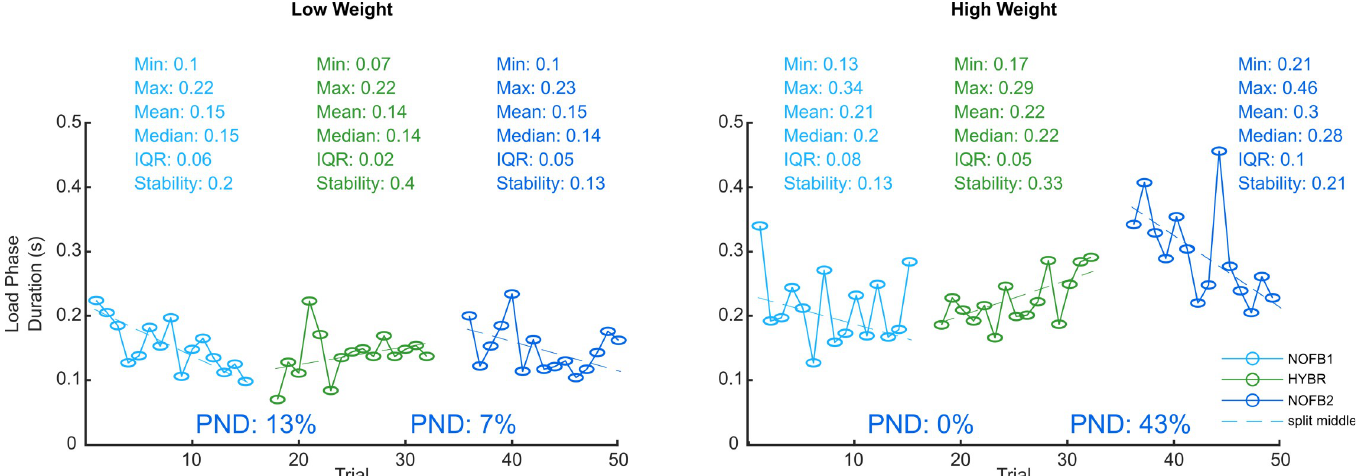
Fig 4. Time series of the load phase duration with and without HYBR feedback in Task 1 of Study 2. The trials without feedback are presented in blue, the trials in green are with HYBR feedback. This example shows that there is an almost complete overlap of trials without and with feedback. PND = Percentage of non-overlapping datapoints between two adjacent phases (in the desired direction, i.e., “HYBR lower than NOFB”); IQR = interquartile range; Stability = percentage of datapoints that are within 15% of the median.